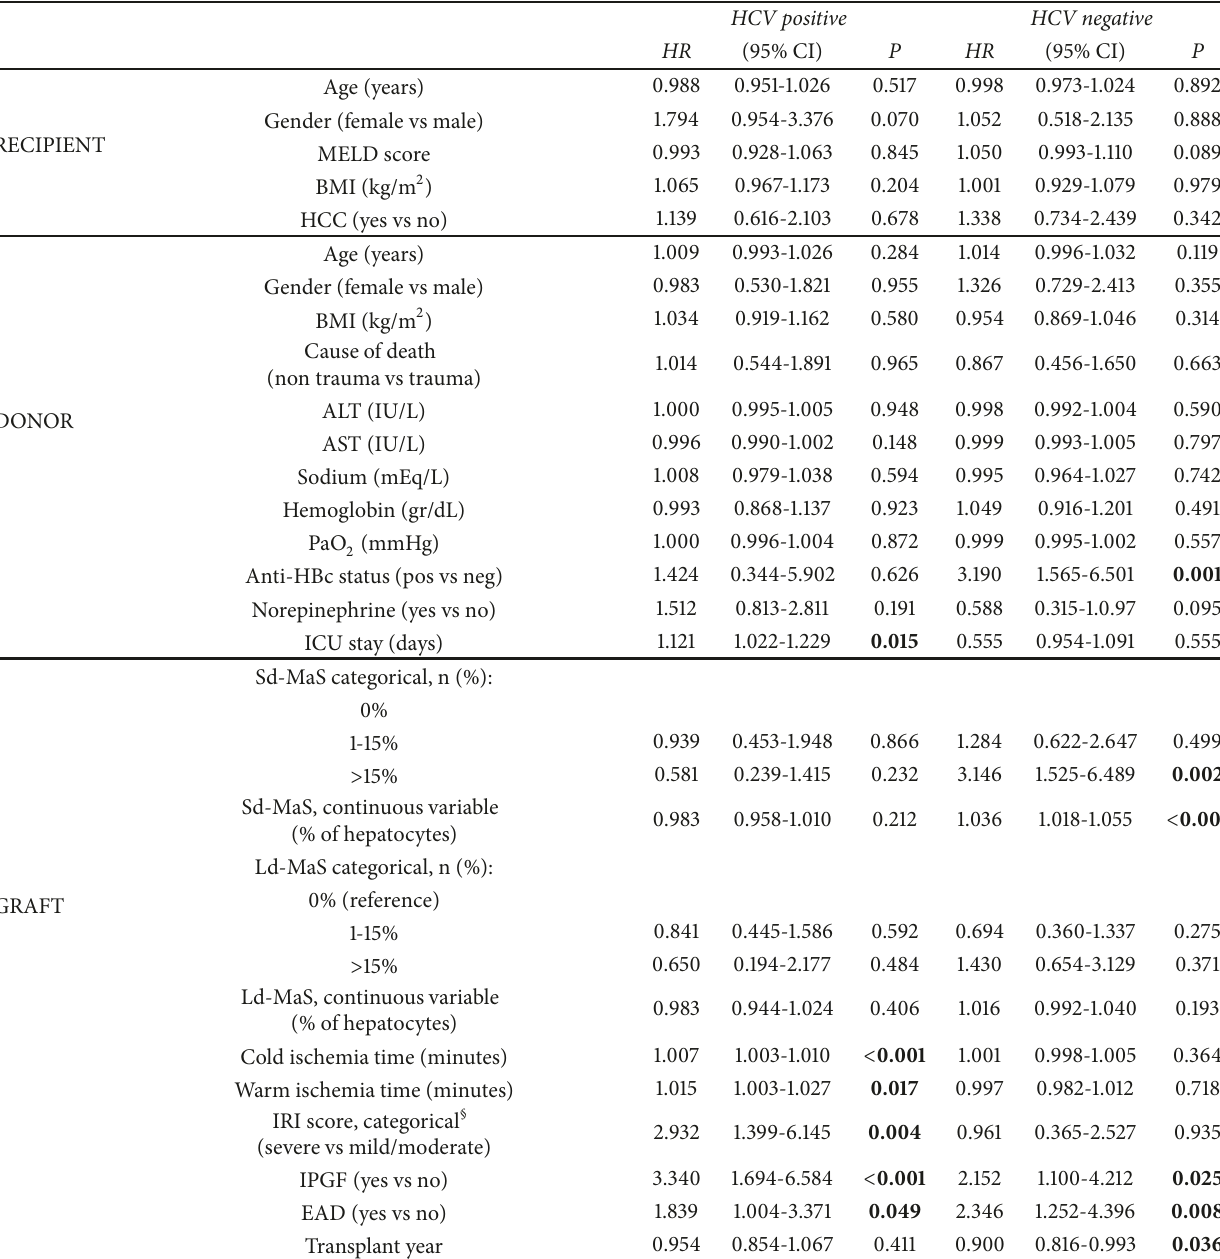
Table 2: Univariable Cox regression analyses for overall graft loss according to recipient etiology of liver disease (HCV negative versus HCV